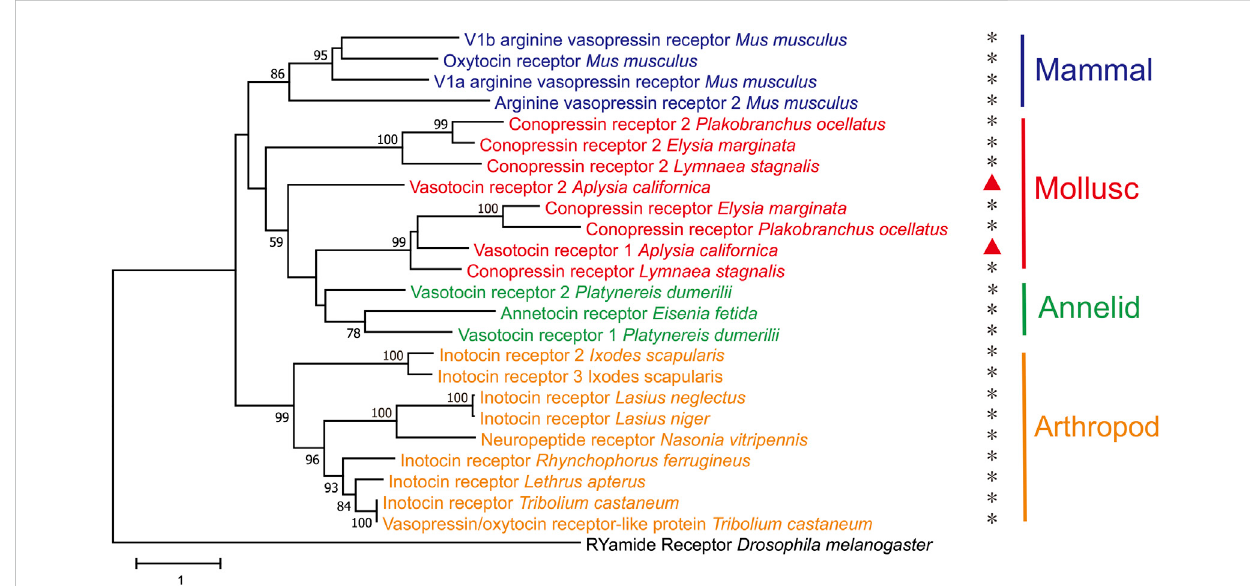
A phylogenetic tree of two Aplysia vasotocin receptors with veri fi ed vasopressin/oxytocin-like peptide receptors in both protostomes and deuterostomes. The tree was generated using MEGA X with 1,000 replicates (See the bioinformatic section in Methods for more details and Supplementary Table S4 for information on the sequences). “ * ” indicates that the receptor has been studied/veri fi ed. “ RYamide receptor_ Drosophila melanogaster ” was used as an outgroup. The tree is drawn to scale, with branch lengths measured in the number of substitutions per site. Numbers at the nodes are bootstrap values as a percentage. Only bootstrap values greater than 50 are